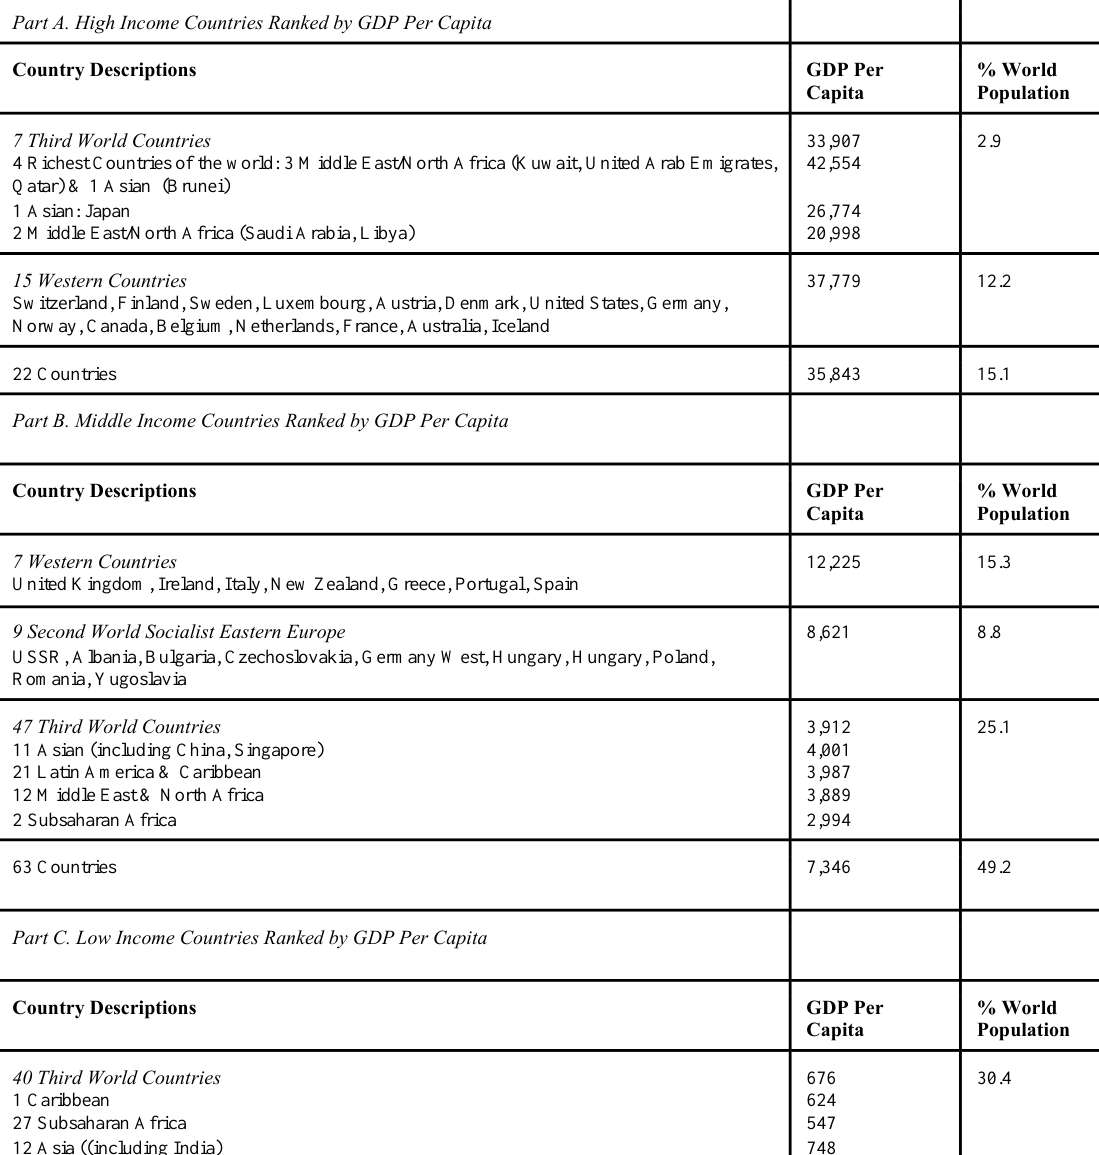
Table 2. The Three Worlds of the Cold War: Ranking of Countries by Income Level and GDP Per Capita, 1980 Part A. High Income Countries Ranked by GDP Per